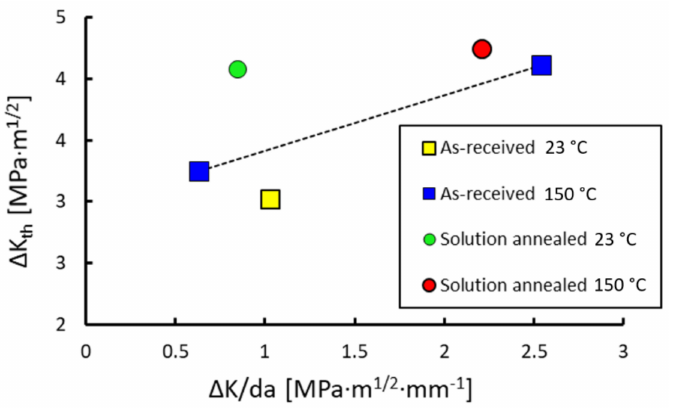
Figure 8. Influence of the load decreasing gradient C = − d ∆ K/da on the threshold value measured at the supposedly closure-free load ratio R =